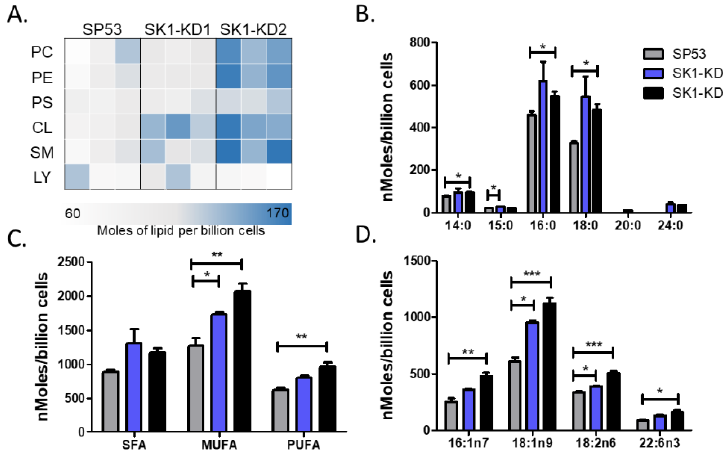
Figure 5. Lipidomic analysis of SP53 and SK1-KD MCL cell lines. ( A ) Lipidomic analysis of lipid classes in SP53, SK-KD1, and SK1-KD2 cell lines. Three biological replicates of each cell line were analyzed using differential mobility spectroscopy to determine the total number of moles of each lipid class present per billion cells. The average number of moles per billion cells for cardiolipins of different ( B ) acyl chain lengths, ( C ) saturation, and ( D ) select species were graphed for each of the three cell lines. Data was analyzed by one-way ANOVA * p < 0.05; ** p < 0.001; *** p < 0.0001.